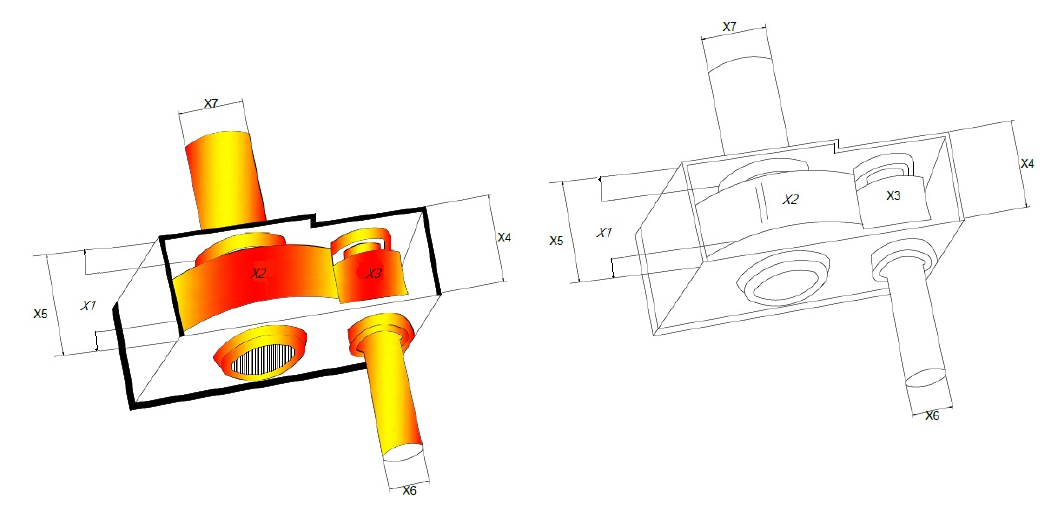
Figure 10. Speed reducer design problem [47]. Table 18. Minimization results of speed reducer design.